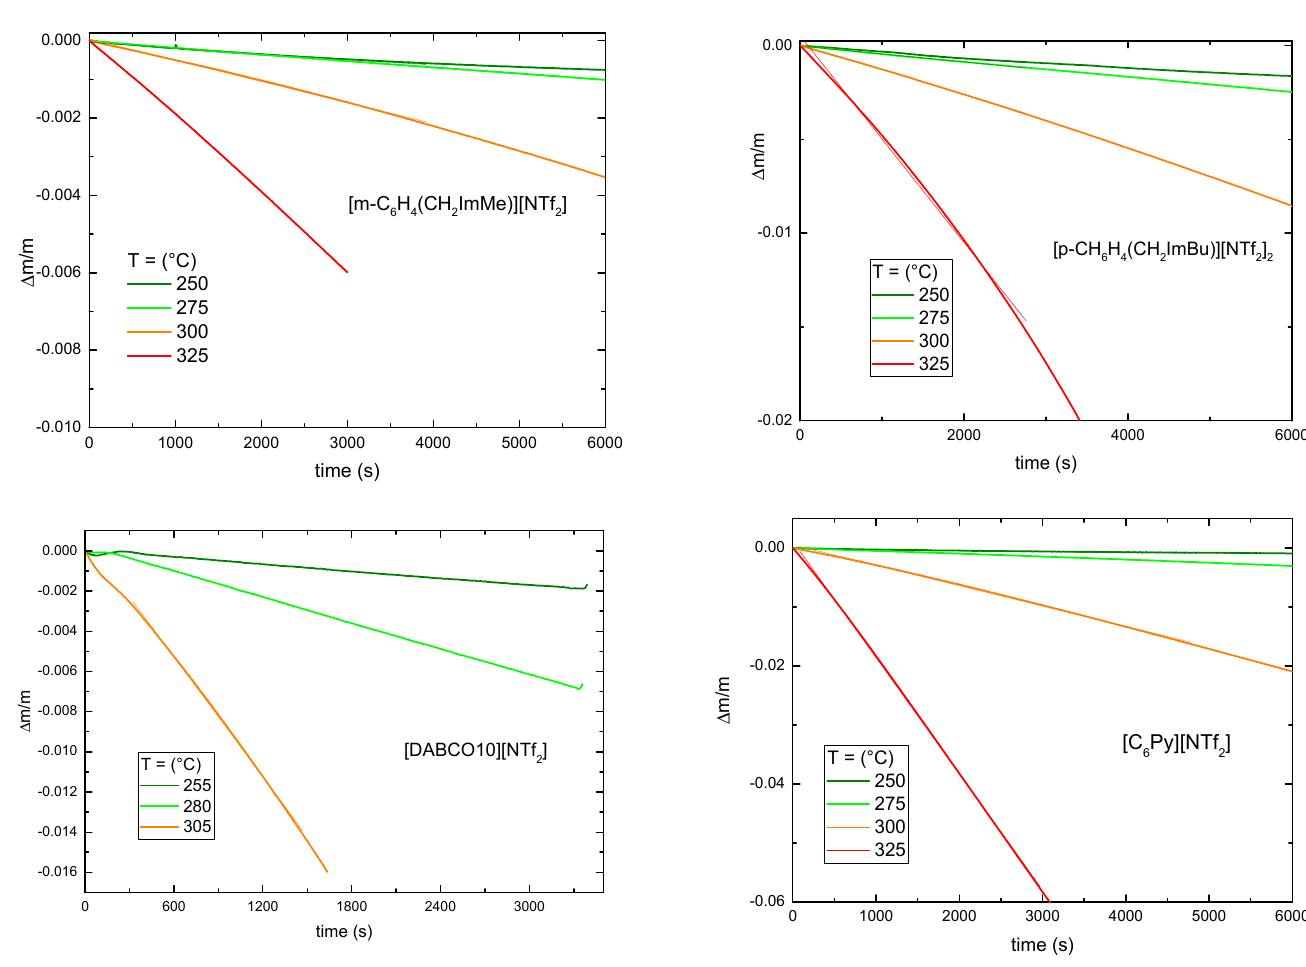
Figure 3. Time dependence of the relative mass loss at selected temperatures for the four ionic liquids (thicker lines) and best fit lines (thinner lines).